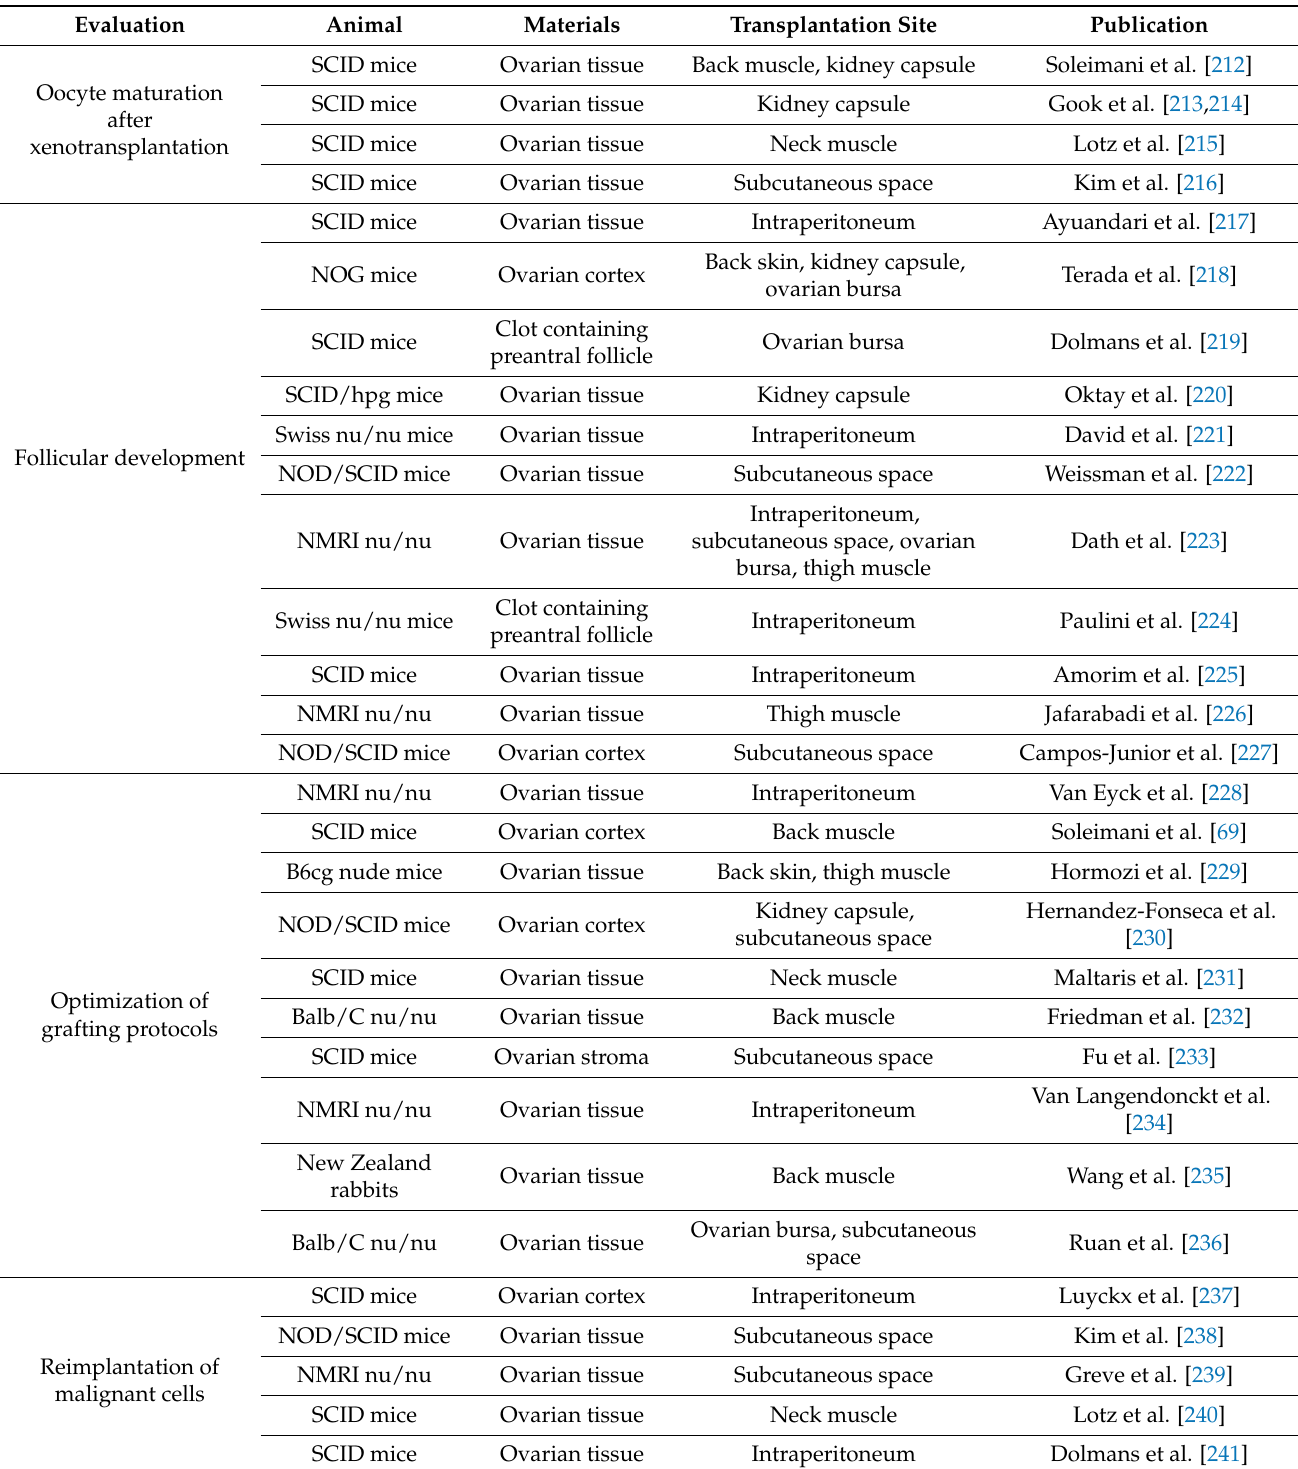
Table 2. Experiments which evaluated the feasibility of human ovarian xenotransplantation into